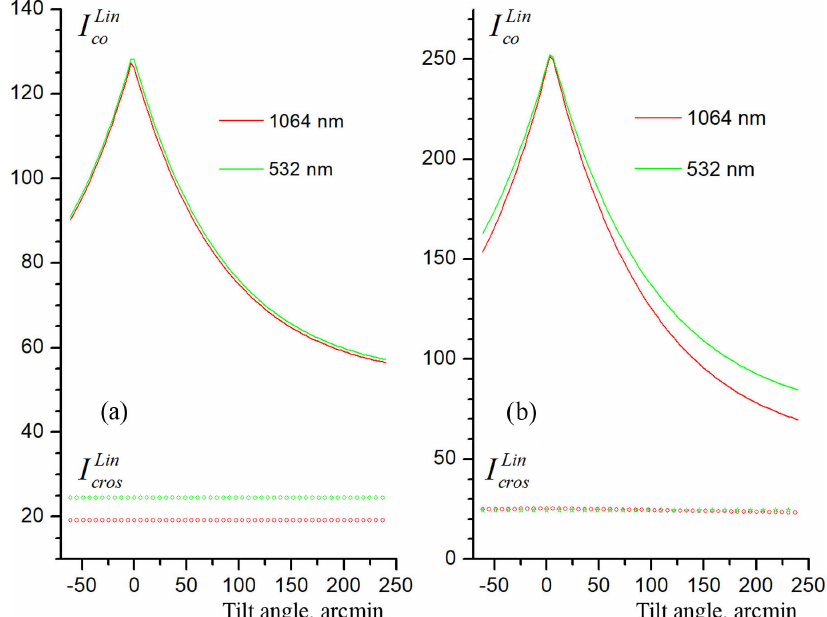
Figure 13. Angular dependencies of polarization components for 532nm (green) and 1064nm (red). Two cases with the maximum angular differences are shown. In all other cases the distribution width w for 532nm is equal to or bigger than that for